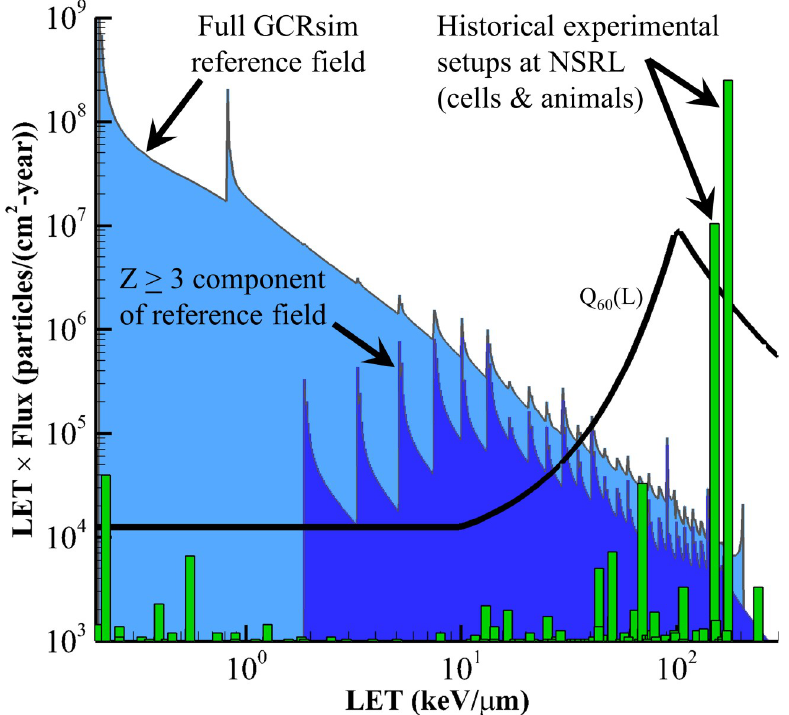
Fig 7. Illustration of beam selection strategy for GCR simulator. The total LET spectrum (light blue) and the HZE spectrum (dark blue) are shown separately. The green bars are representative of the number of single-ion beam experiments performed at NSRL as a function of LET (scaled for plot clarity). The black line is representative of ICRP- 60 quality factor weighting [11] to estimate biological damage (scaled for plot clarity). Plot data available in S1 Data. GCR, galactic cosmic radiation; HZE, high charge and high energy ions; ICRP, International Commission on Radiological Protection; LET, linear energy transfer; NSRL, NASA Space Radiation Laboratory.